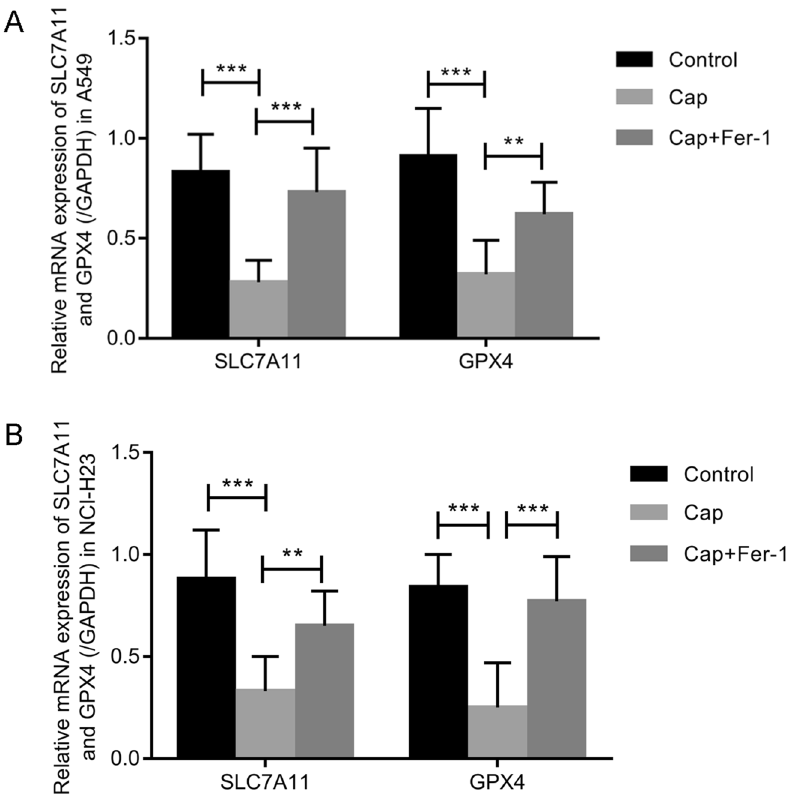
Figure 3. The expressions of SLC7A11 and GPX4 were analyzed by real-time PCR. ( A ) SLC7A11 and GPX4 mRNA expressions in A549 cells. ( B ) SLC7A11 and GPX4 mRNA expressions in NCI-H23 cells. (** P < 0.001, *** P <